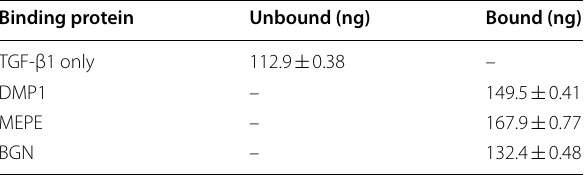
The value indicates total ng of TGF-β1 obtained from IE-HPLC after binding experiments against 20 μg of protein